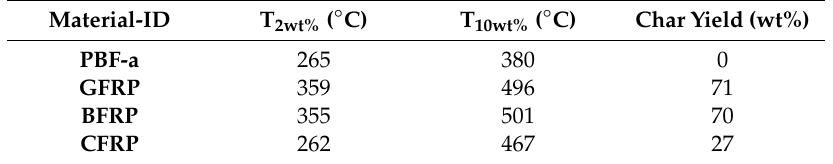
Table A5. Thermal-oxidative decomposition of carbon, glass and basalt fiber reinforced PBF-a.